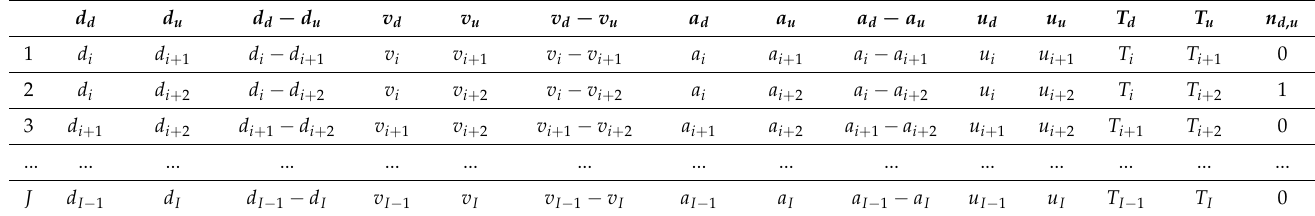
Table 5. Data structure defined for the disaggregated